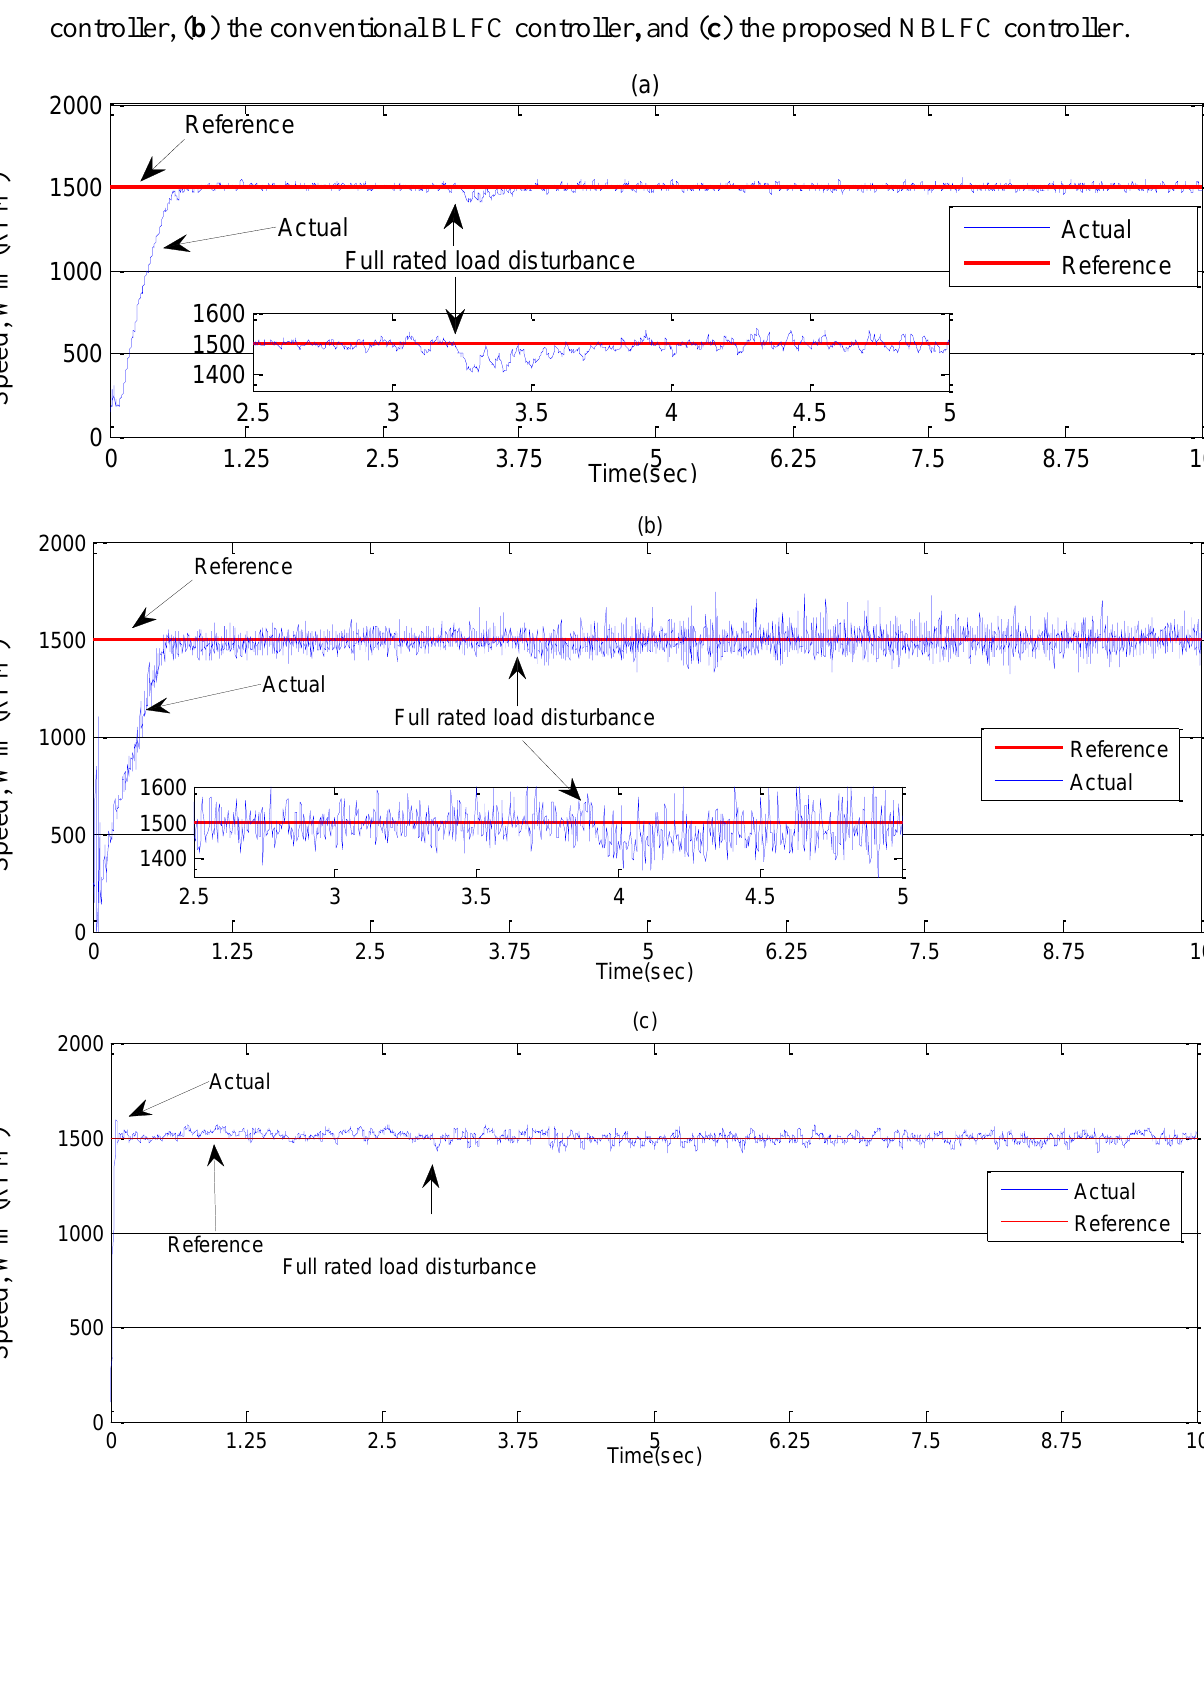
Figure 19. Experimental speed responses-based IM drive in Case-2 ; ( a ) the tuned PI controller, ( b ) the conventional BLFC controller , and ( c ) the proposed NBLFC